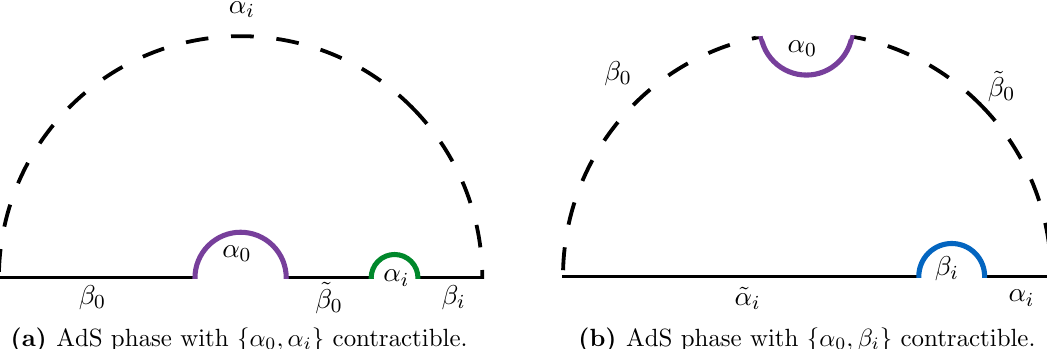
Figure 6 . One quarter of the Schottky domains used to construct the two AdS phases, reduced by the re(cid:13)ection symmetries in the x-axis and the inversion symmetry through the unit circle (dashed). Various boundary cycles are labeled in each